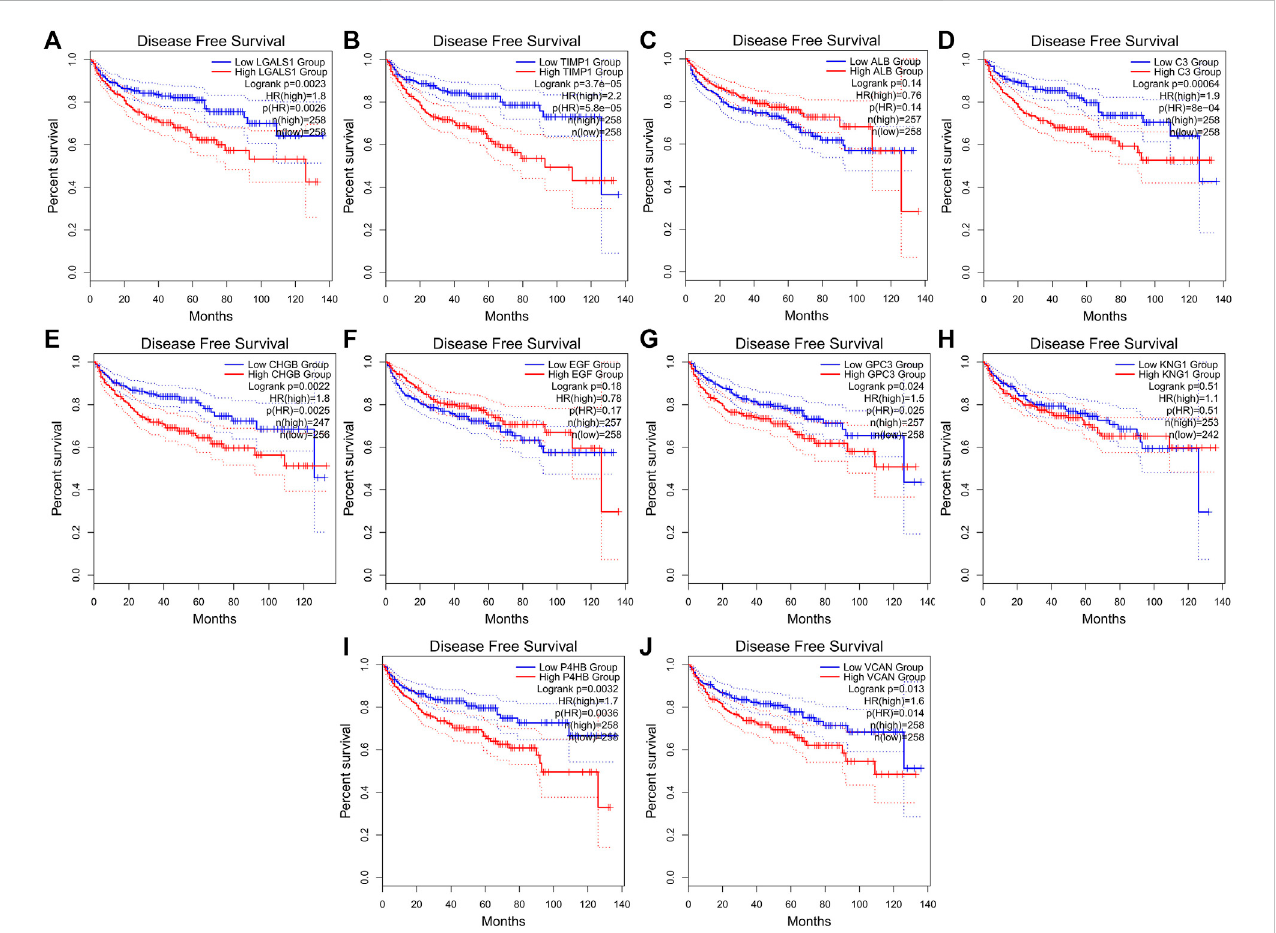
FIGURE 9 Disease-free survival (DFS) analysis ofthetenhub genes ofccRCC patients inthe GEPIA2 database. (A) Survival analysis for LGALS1 inccRCC. (B) Survival analysis for TIMP1 in ccRCC. (C) Survival analysis for ALB in ccRCC. (D) Survival analysis for C3 in ccRCC. (E) Survival analysis for CHGB in ccRCC. (F) Survival analysis for EGF in ccRCC. (G) Survival analysis for GPC3 in ccRCC. (H) Survival analysis for KNG1 in ccRCC. (I) Survival analysis for P4HB in ccRCC. (J) Survival analysis for VCNA in